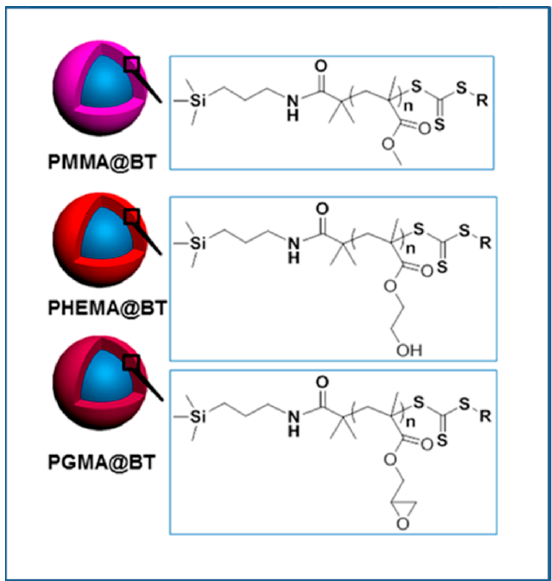
Figure 14. BaTiO 3 core-shell nanoparticles by surface-initiated RAFT polymerization. Reproduced with permission from Ref. [197].